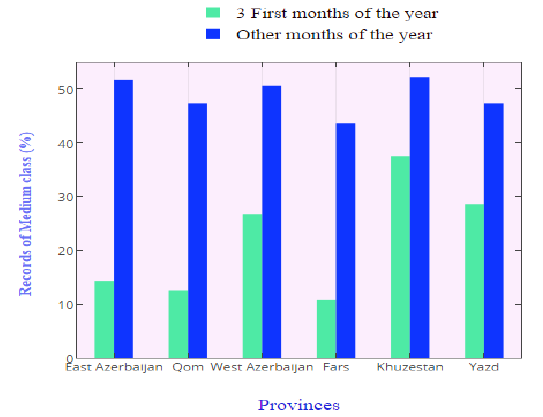
Figure 9. Comparison between spring and rest of year's